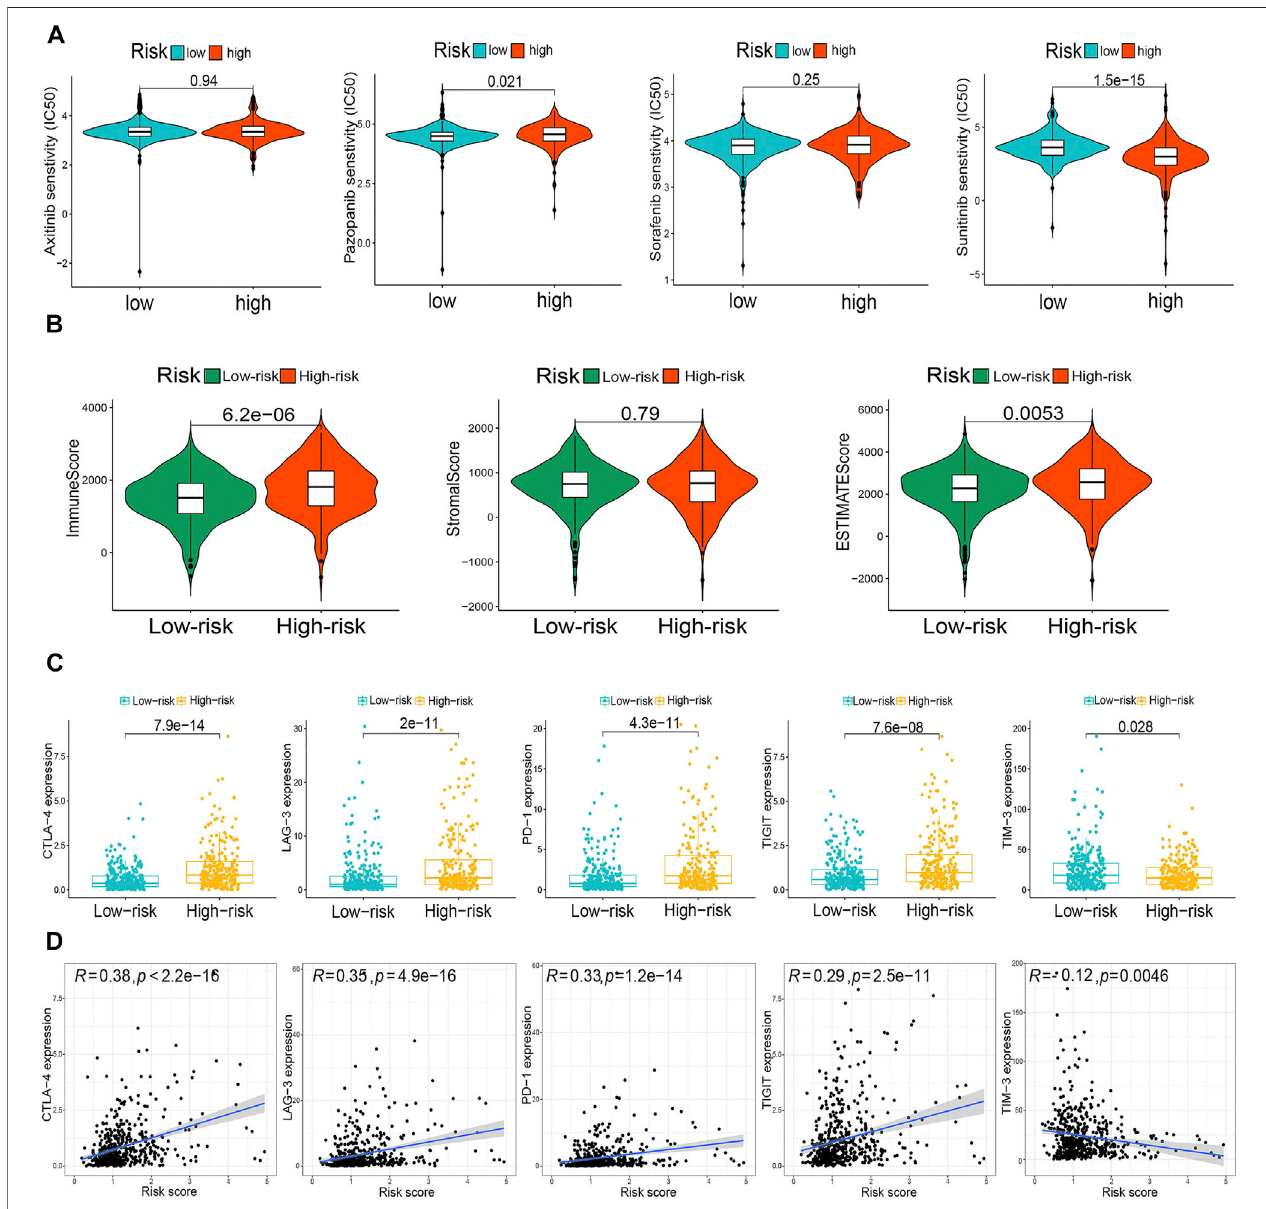
FIGURE 11 | The m6A-RLPS is related with the tumor microenvironment (TME) immune reaction. (A) Differential drug sensitivity. (B) Distribution of TME scores in the risk groups. (C) Differential expression of fi ve immune checkpoints in the risk groups. (D) Nearly all selected immune checkpoints correlated positively with the risk